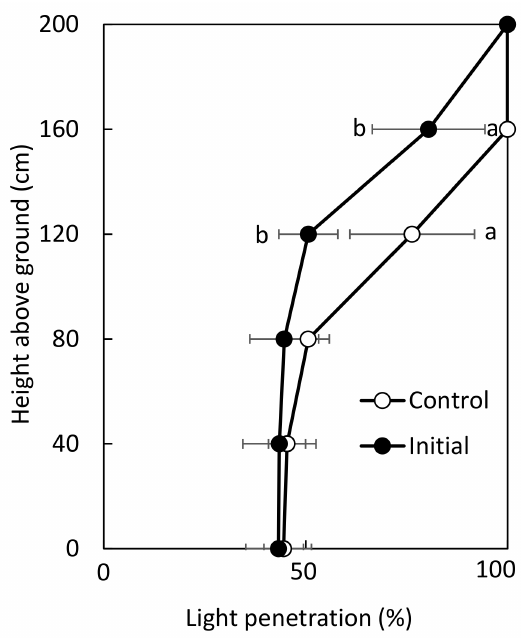
Figure 7. Light transmittance rate through different canopy levels in August. The value shown is an average of readings from the control ( ) and initial fertilization treatment ( • ). Different letters (cid:35) represent statistically significant differences ( p < 0.05) between the